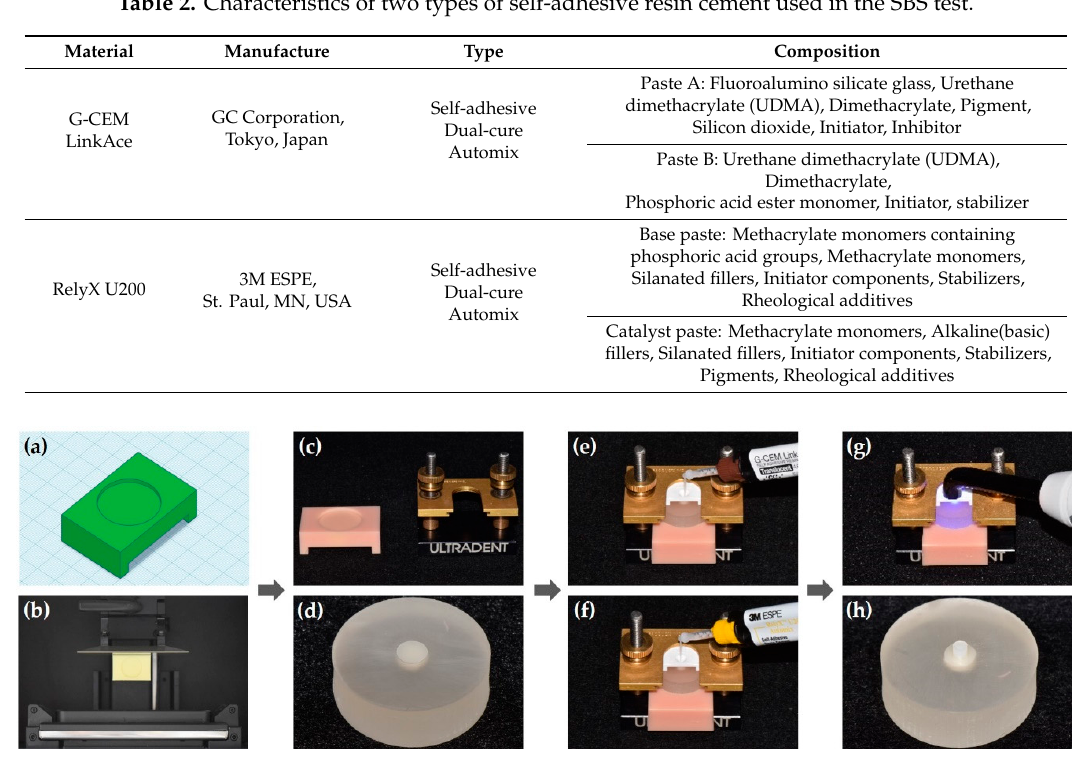
Table 2. Characteristics of two types of self-adhesive resin cement used in the SBS test.